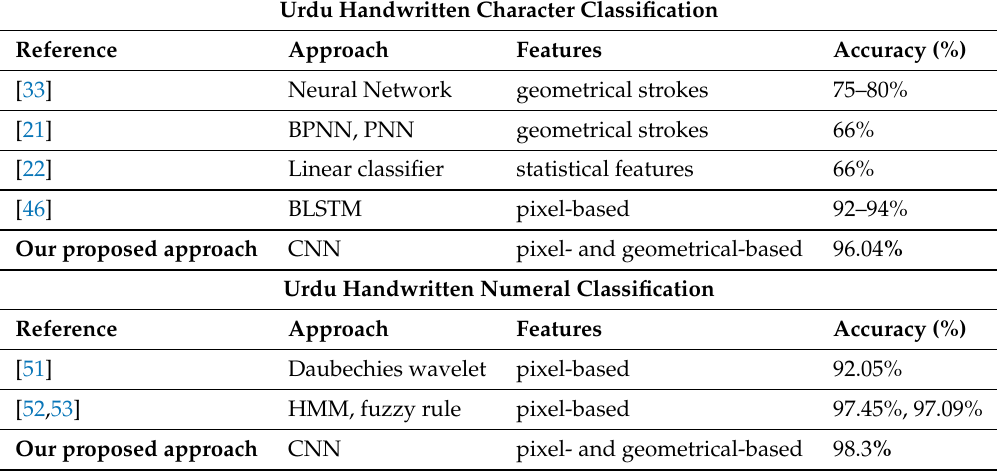
Table 4. Comparison of our proposed approach for Urdu handwritten character classification with other techniques.